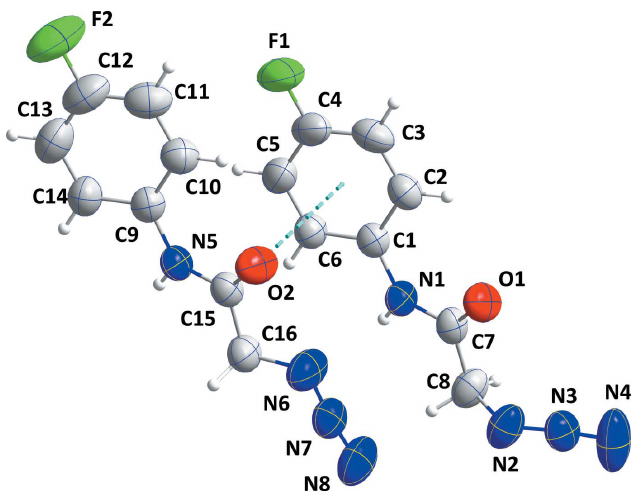
Figure 1 The asymmetric unit with labeling scheme and 50% probability